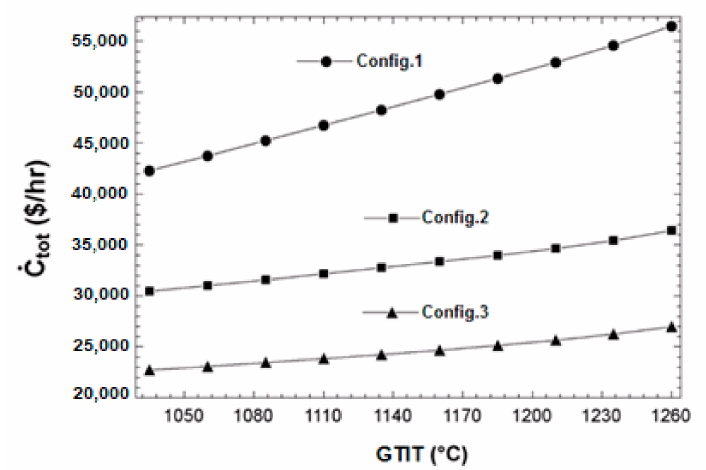
Figure 11. Effect of gas turbine inlet temperature change on the overall cost rate.